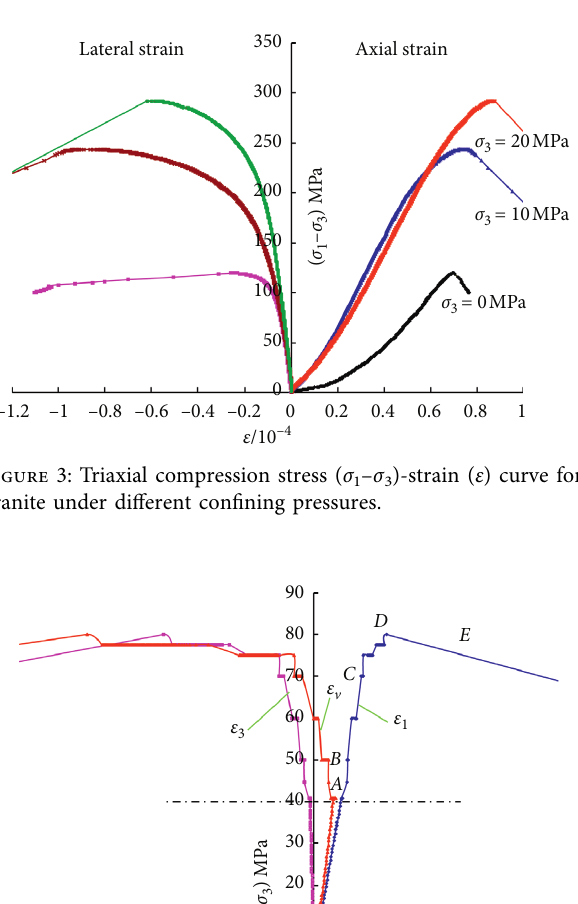
Figure 4: Relationship between deviatoric stress ( σ